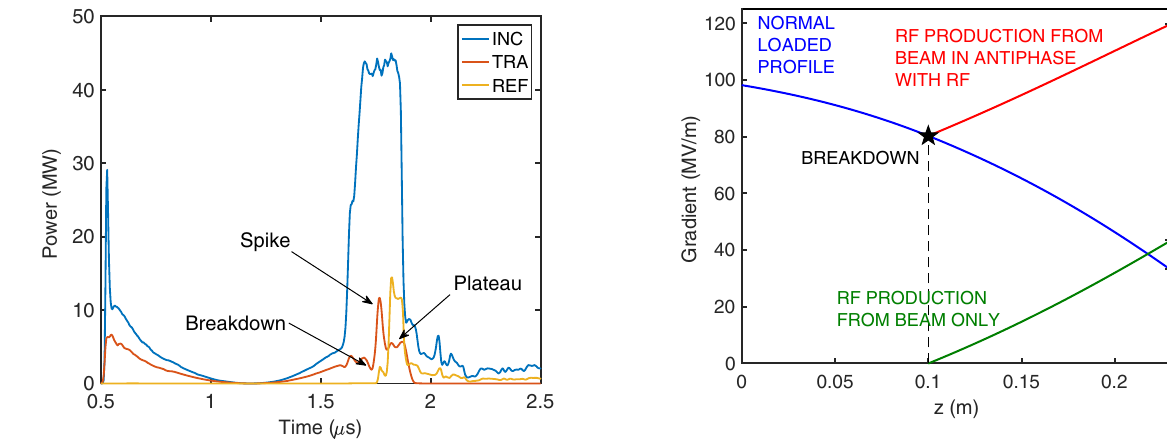
FIG. 7. rf power signals in the case of a breakdown with beam. The same color coding of Fig. 5 is used. Fast power spikes in the signals, like the spike at 0 . 6 μ s in the blue trace are artifacts of the DAQ system. The consistency of the spikes in the transmitted power, object of this section, have been validated using a parallel detector system based on diodes.